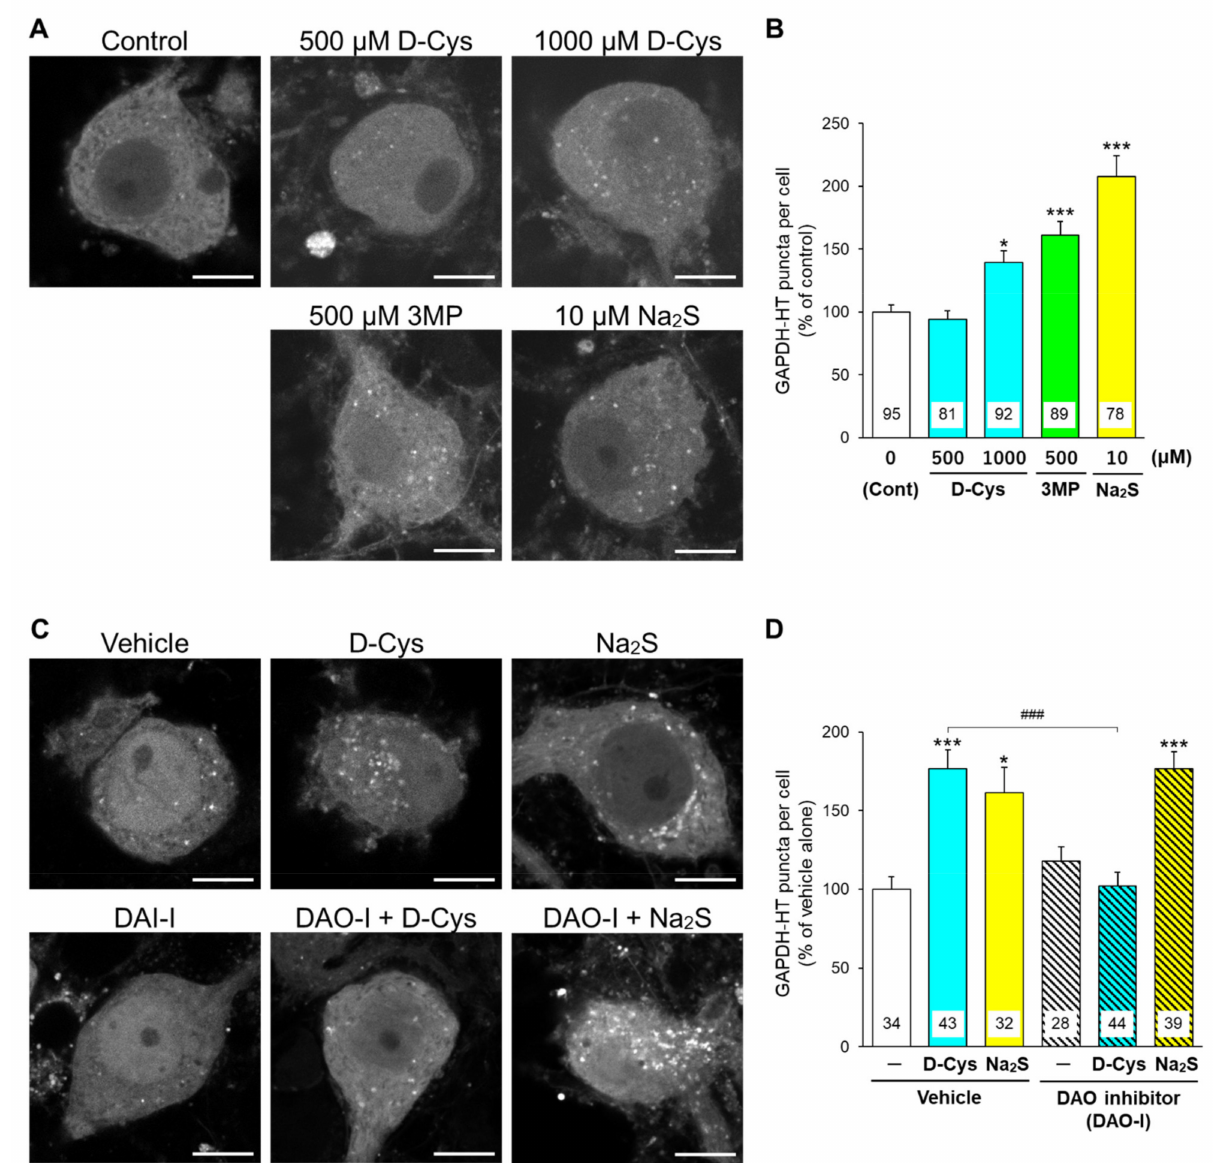
Figure 2. Effects of D-cysteine, 3MP, and Na 2 S on CMA/mA activity in primary cultured PCs. ( A ) Punctate accumulation of GAPDH-HT in primary cultured PCs treated with D-cysteine (D-Cys, 500 and 1000 µ M), 3MP (500 µ M), and Na 2 S (10 µ M) for 24 h. Control (Cont) refers to cells without treatment. ( B ) Quantitative analyses of GAPDH-HT puncta shown in A. ( C ) Punctate accumulation of GAPDH-HT in AD293 cells treated with D-cysteine (1000 µ M) and Na 2 S (10 µ M) in the presence of vehicle (0.1% dimethyl sulfoxide) or DAO inhibitor (DAO-I, 5 µ M) for 24 h. ( D ) Quantitative analyses of GAPDH-HT puncta are shown in C. Scale bars = 10 µ m. Numbers in the columns represent the numbers of observed cells. * p < 0.05, *** p < 0.001 vs. control or vehicle alone, ### p < 0.001 (Dunn’s multiple comparisons